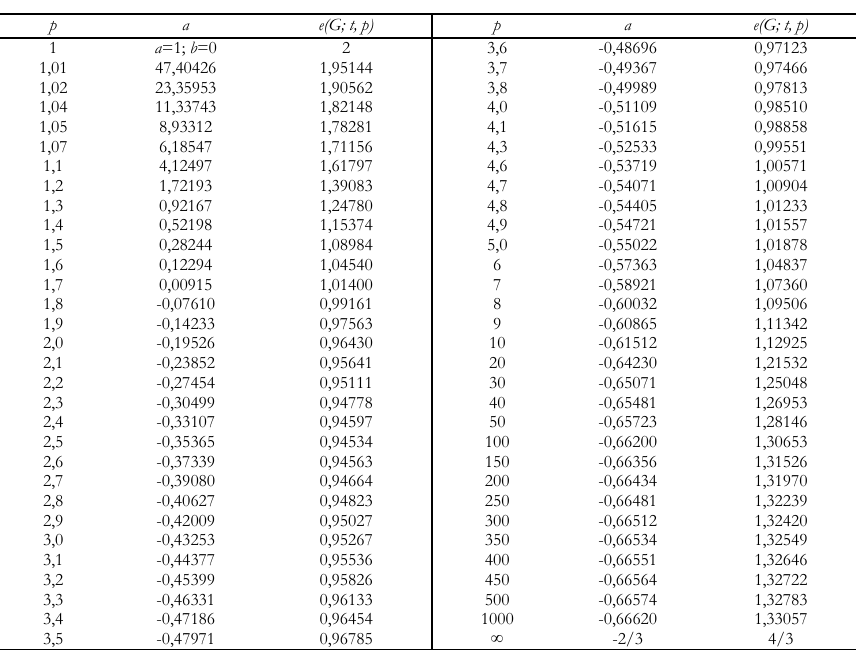
Values of a (b=1) maximising the Pitman efficiency e(G; t,